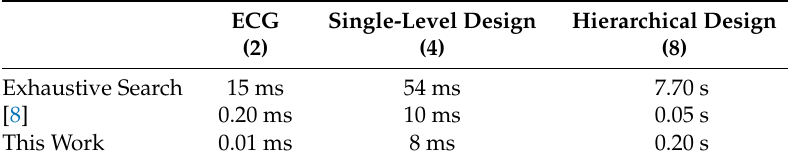
Table 4. Execution time of the three algorithms on three benchmark designs. The numbers in parentheses show the number of modules in that